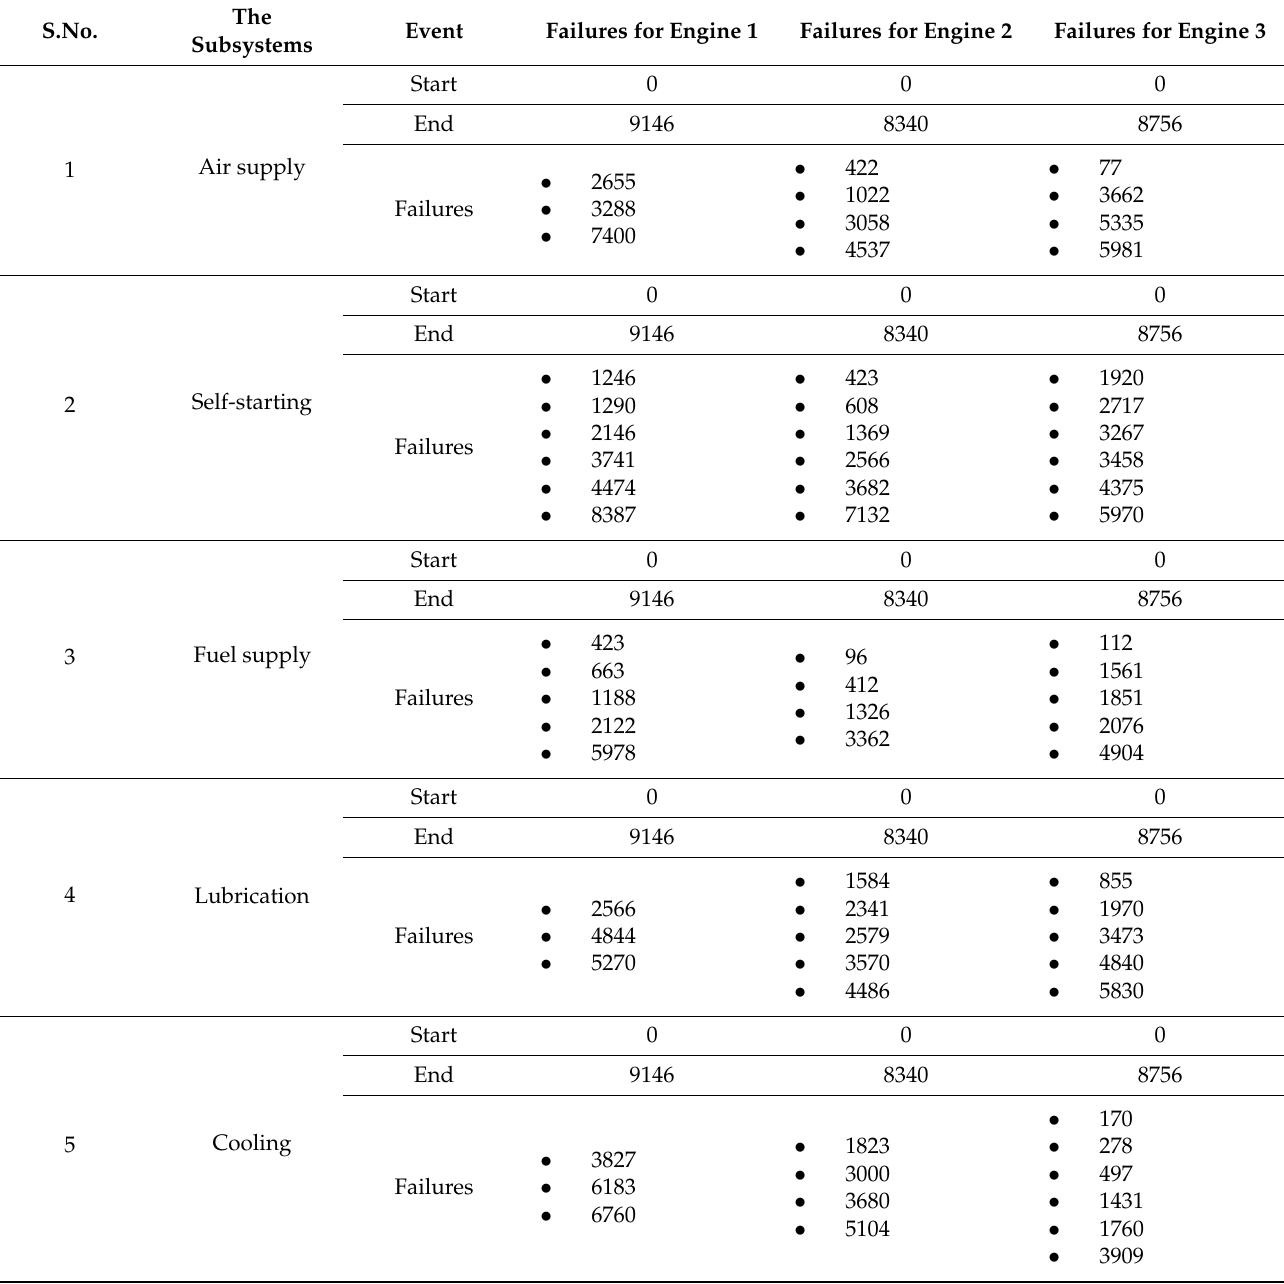
Table 3. Common Beta Hypothesis test failure data in